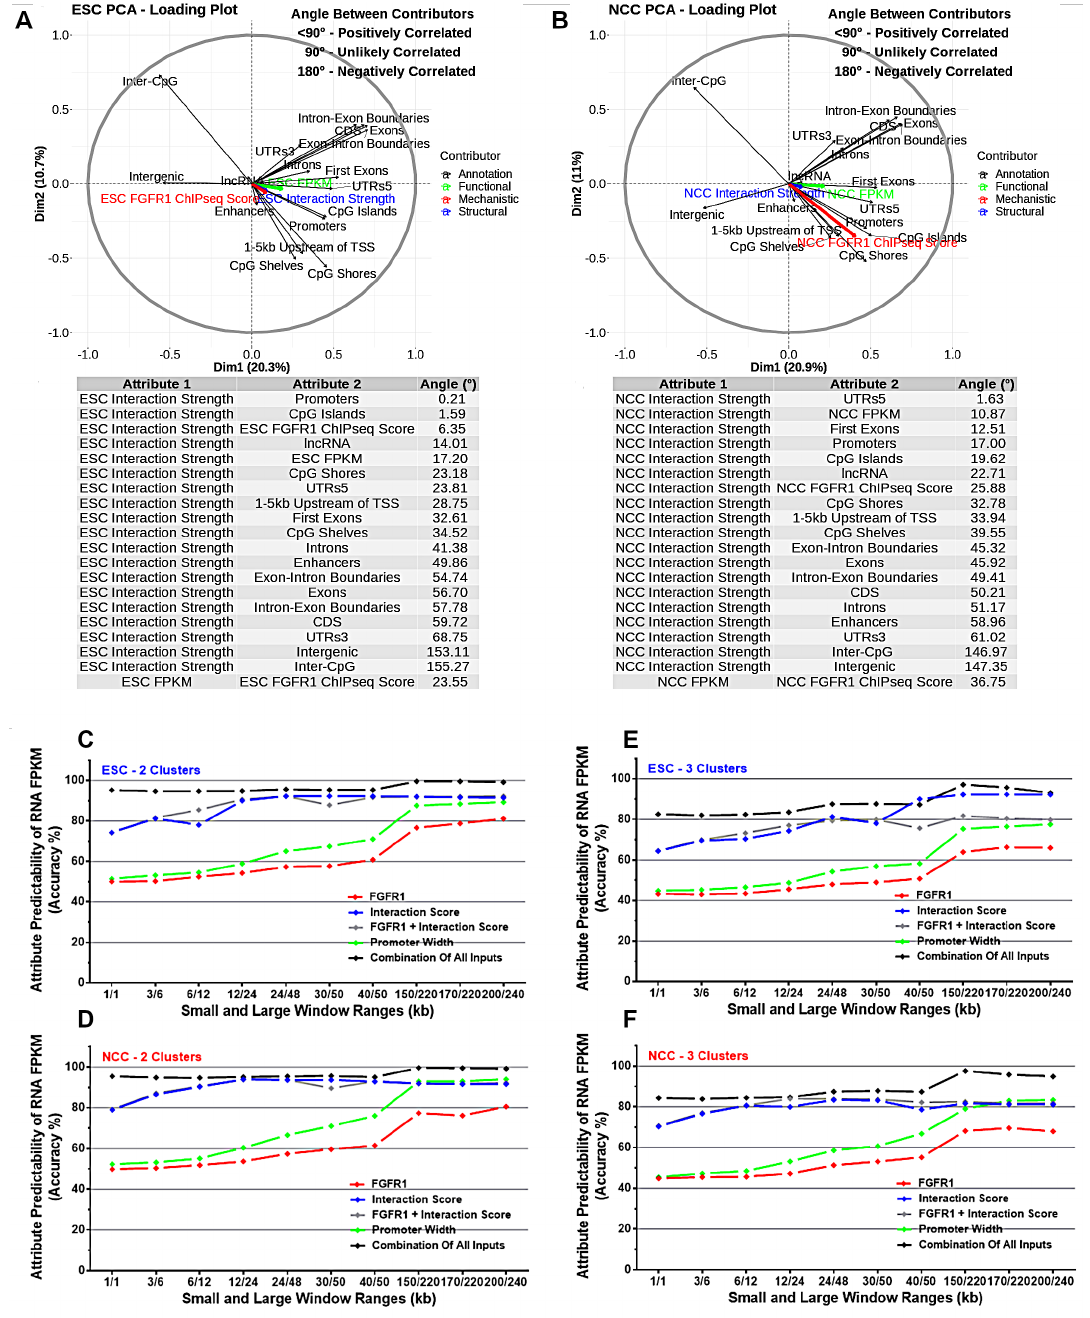
Figure 2. Interactions correlate with gene coding, regulatory features, and nFGFR1 binding. Interactions, gene coding and regulatory features, and nFGFR1 are predictive of RNA expression. ( A , B ) PCA on ESC and NCC full genome measurements of correlations between interaction anchor strength, gene coding and regulatory features, and nFGFR1 binding. ( C – F ) Deep Neural Network machine learning using a two-window approach prediction model of interaction strength, gene coding and regulatory features, and nFGFR1 binding for prediction of RNA expression. ( C , D ) Two output categories (<1 or >=1 FPKM clusters) or ( E , F ) 3 categories (<1, 1–30, and >30 FPKM clusters) in ESC and NCC using window-ranges of 1/1–200/240 kb were used for prediction of RNA expression from interaction strength, gene coding and regulatory features, and nFGFR1. A two-window range (ranges in kb) neural network prediction model was applied in which a smaller window as a numerator contains the attributes used for prediction (FGFR1 binding, interaction strength, genome structural features, or combinations of them), and a larger (or equal to) window as a denominator contains region within which the RNA FPKM level is predicted. Analysis was completed using Keras, to build a deep neural network capable of providing high levels of accuracy for FPKM class